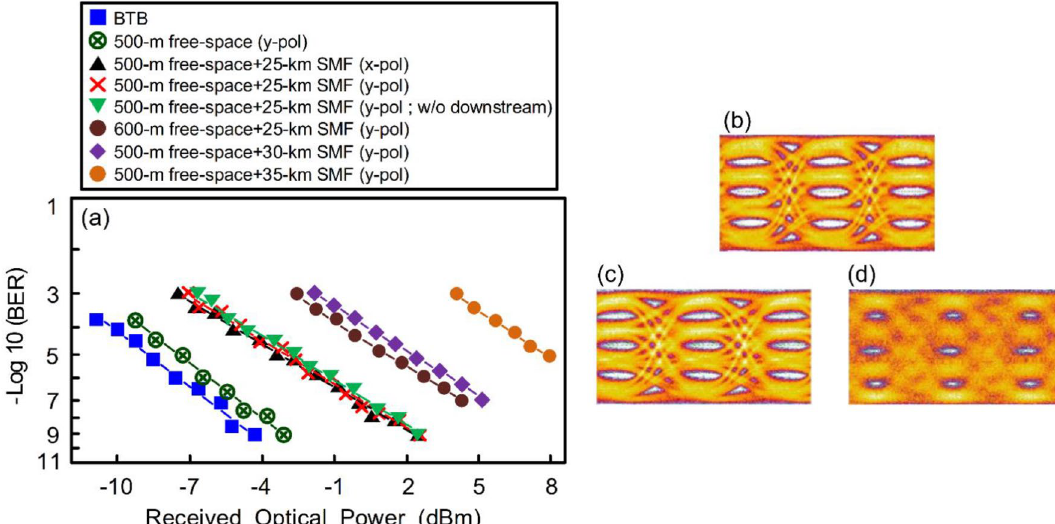
Figure 3. ( a ) The BER performances of 256 Gbit/s PAM4-based fibre-FSO converged system (uplink transmission) in sunny weather under the scenarios of BTB ( y -polarisation), over 500-m free-space transmission ( y -polarisation), over 500-m free-space and 25-km SMF transmissions ( x - and y -polarisations), over 600-m free-space and 25-km SMF transmissions ( y -polarisation), over 500-m free-space and 30-km SMF transmissions ( y -polarisation), as well as over 500-m free-space and 35-km SMF transmissions ( y -polarisation). The eye diagrams of 56 Gbit/s PAM4 signal under the conditions ( b ) over 500-m free-space transmission ( y -polarisation), ( c ) over 500-m free-space and 25-km SMF transmissions ( y -polarisation), and (d) over 600-m free-space and 25-km SMF transmissions ( y